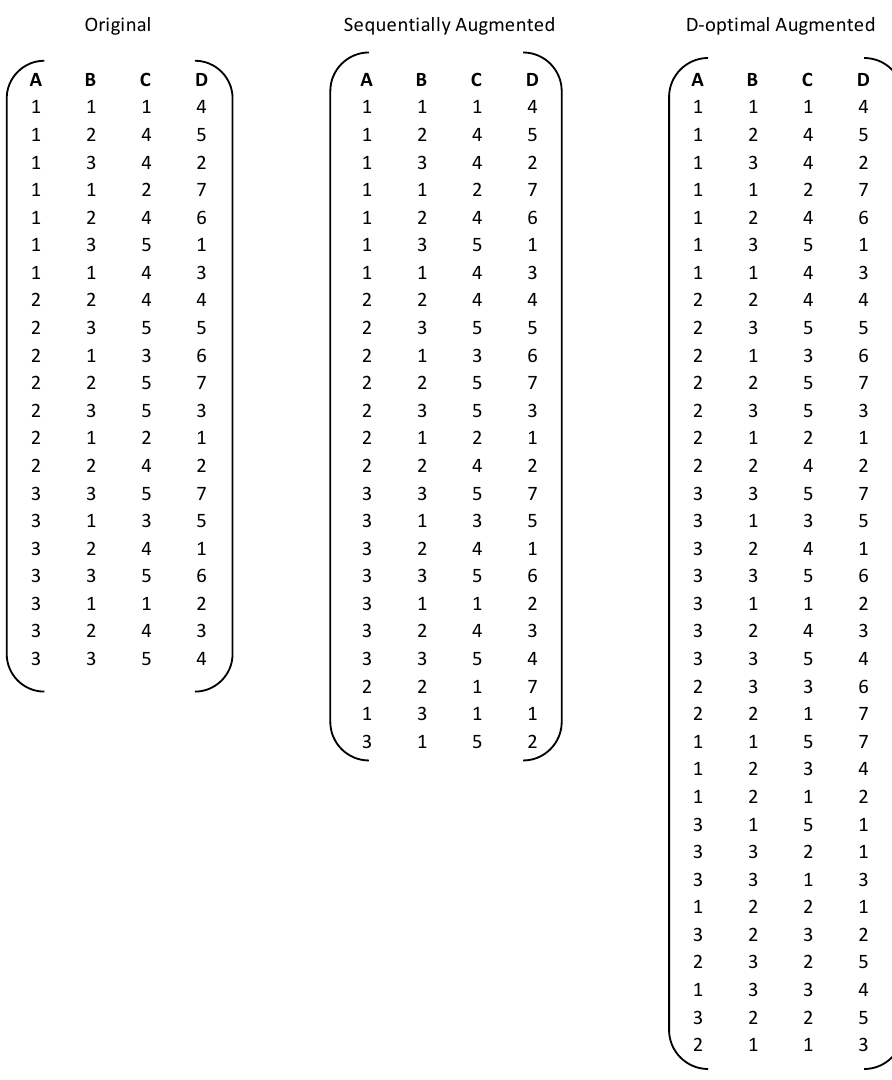
Figure 17. Original, sequentially augmented, and D-optimal augmented designs.